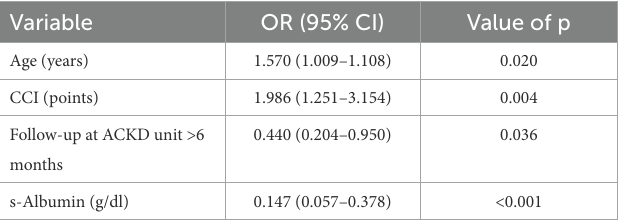
TABLE 5 Multivariate binary regression analysis of factors associated with the decision-making to choose home-based renal replacement therapy.